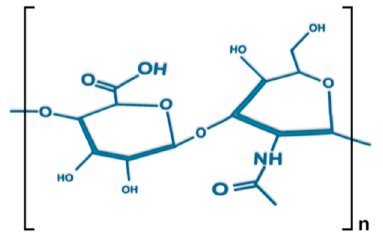
Figure 1. Structure of the disaccharide ( D -glucuronic acid and N -acetyl- D -glucosamine) repeat unit of hyaluronic acid (HA).